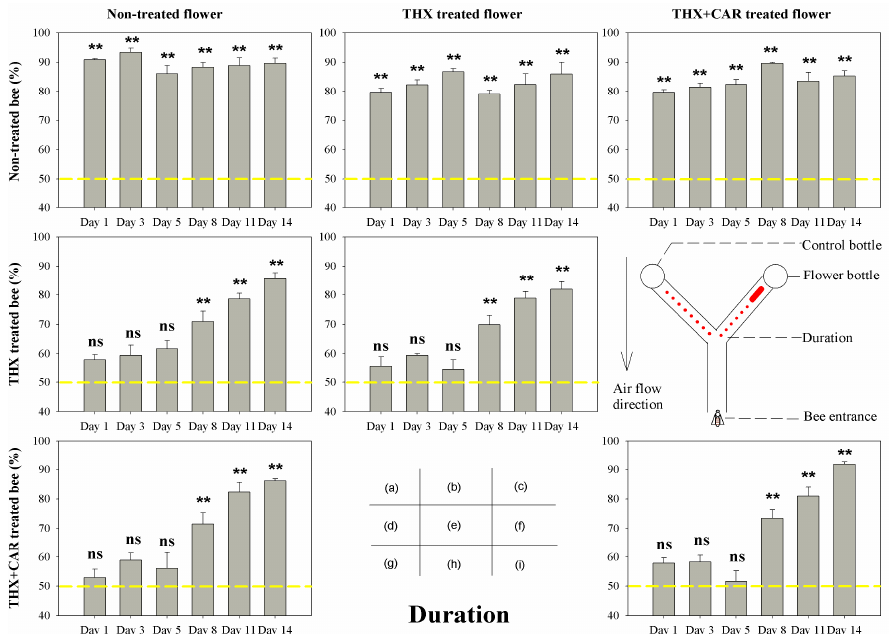
Figure 2. The duration of bee orientation behavior in Y maze treated with thiamethoxam (THX) and thiamethoxam + carbendazol mixture (THX + CAR). The X-axis presented the time post-treatment (Day). The red bold line and the dots in diagram (f) showed the bee wander back and forth between two arms. The yellow dash line showed the reference line of 50%, ** presents great significant difference ( p < 0.01), ns means no significant difference ( p > 0.05).